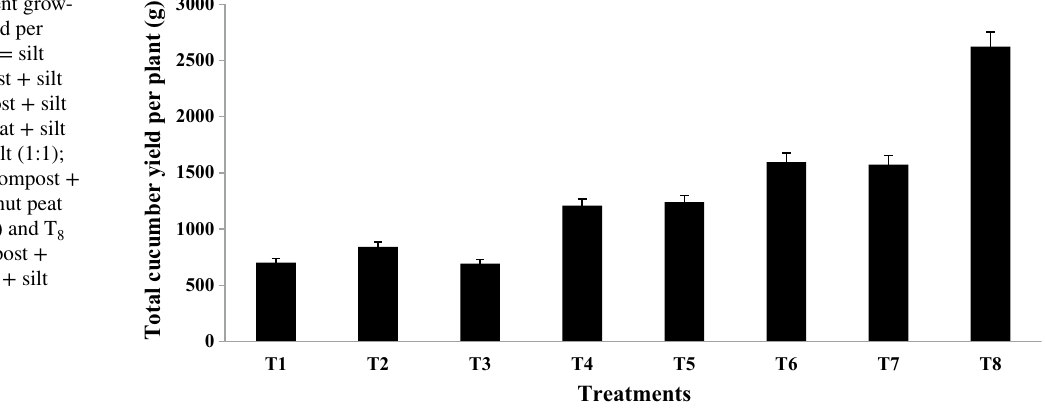
Fig. 1 Effect of different grow- ing media on total yield per plant of cucumber. T 1 = silt